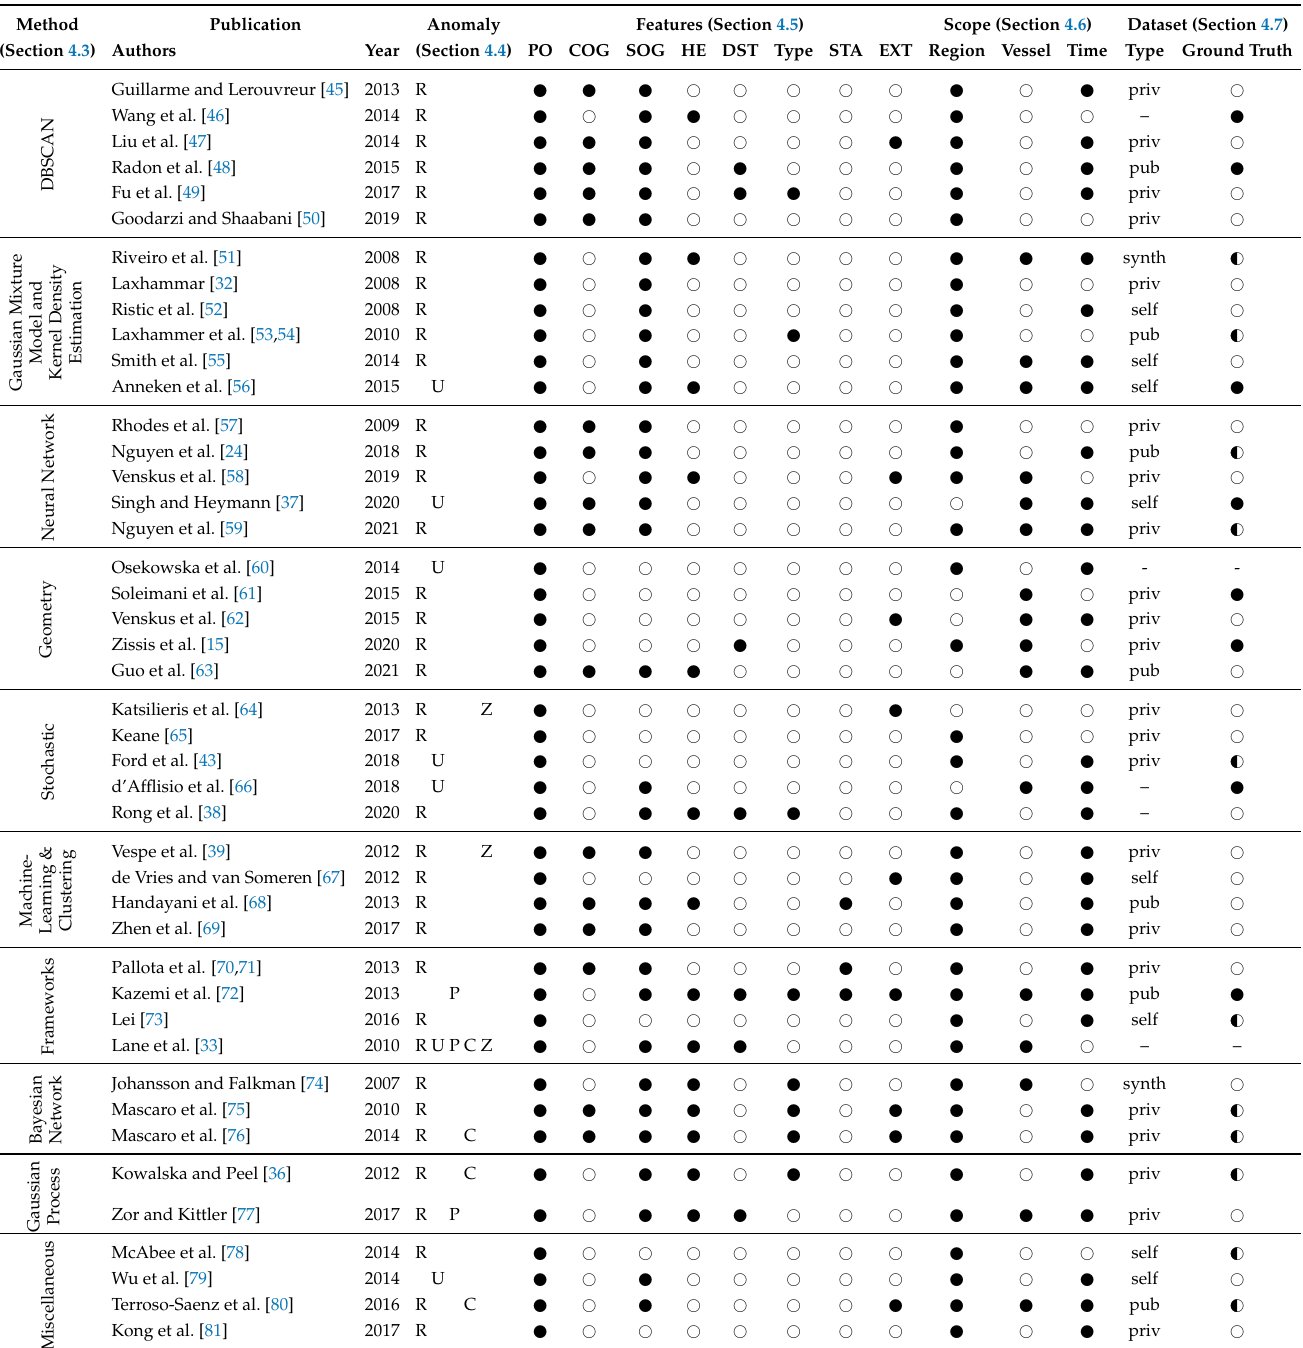
Table 3. Summarized survey results of the 44 anomaly detection approaches for maritime AIS tracks. While the methodologies are quite diverge, we observe large commonalities regarding the anomaly type with route deviation being the most prominent one. Furthermore, the majority of detectors focus on a specific region and thus require re-training in order to be applied in other regions. Moreover, most publications refer to private datasets and struggle to find ground truth of known anomalies for their